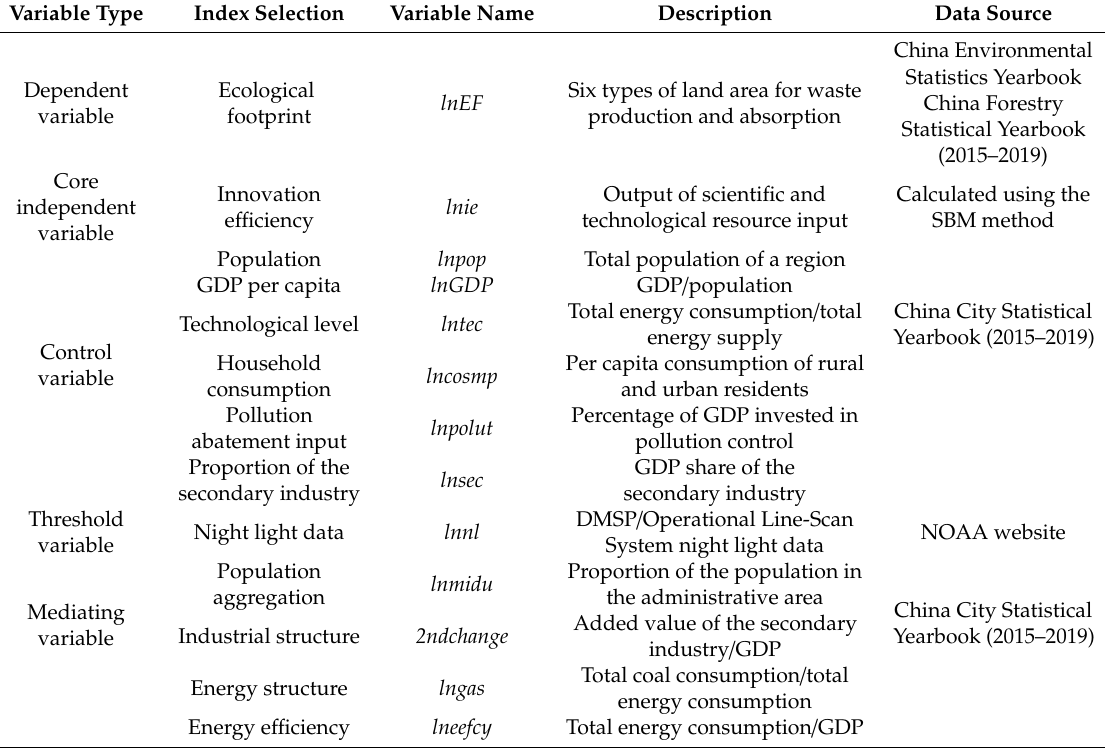
Table 1. Data selection and